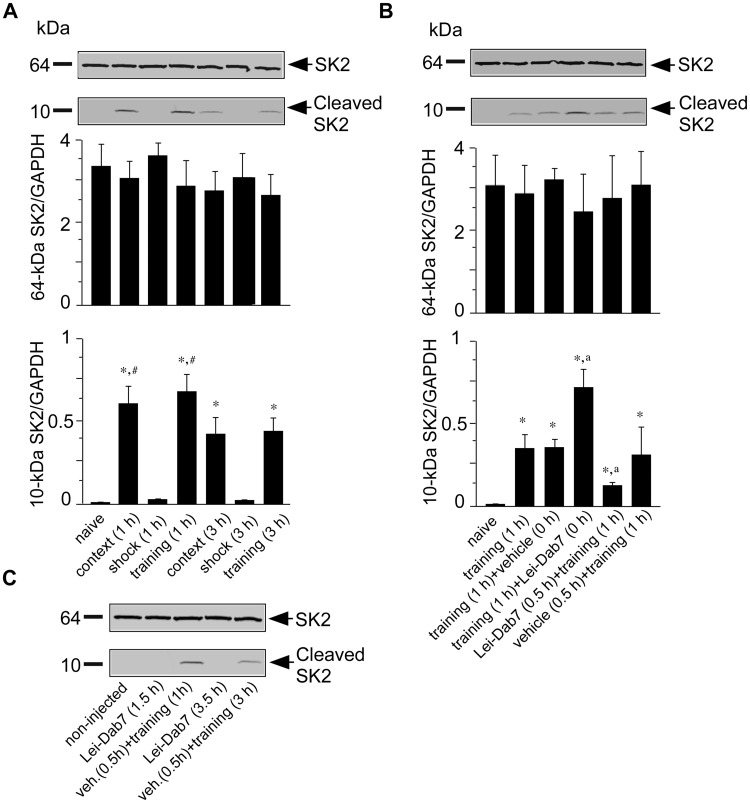
Cleavage of SK2 channel protein after contextual fear conditioning training.Western blot analysis of SK2 protein levels in (A) hippocampal tissue obtained from naïve mice or 1 h and 3 h after training (context+shock). In the context group, mice were exposed to the training context without receiving a foot-shock. In the shock group, mice received a foot-shock immediately after they were exposed to the training context and were removed immediately after the foot-shock. Experiment was performed twice. (B) Representative immunoblot of SK2 protein levels in hippocampal tissue from naïve, trained and trained vehicle- or Lei-Dab7-injected mice. Mice were injected either 0.5 h before or 0 h after training as indicated. Hippocampal tissue was removed 1 h after training. The SK2(538–555) antibody recognized the 64-kDa SK2 protein and a 10-kDa SK2 C-terminal fragment (top). (C) SK2 protein levels in hippocampal tissue from naïve non-injected, Lei-Dab7-injected naïve, or vehicle-injected trained mice. Hippocampal tissue was removed 90 or 210 min after injection (1h and/or 3h after training). The number of individual samples per treatment was five. Data presented are the mean ± SEM. Statistically significant differences: *p < 0.05 versus naive, #
p < 0.005 versus 3 hours context and conditioning groups, a
p<0.05 versus training + vehicle.